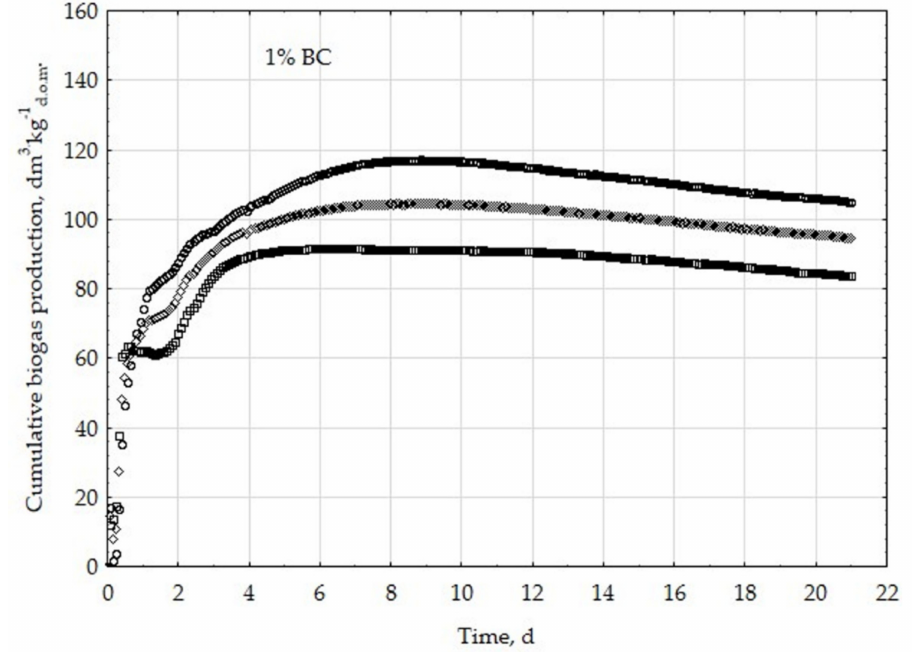
Figure A2. Biogas production from BSG: cumulative curves in variant with biochar addition at the level of 1%. The number of repetitions was